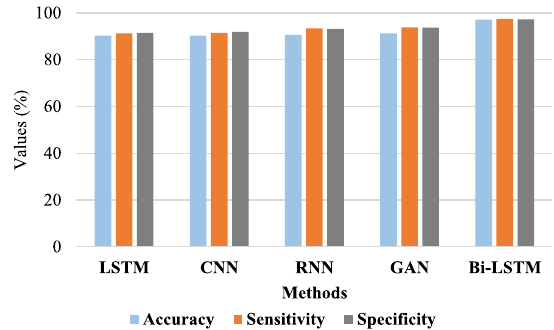
Fig. 9 Comparison of deep learning methods on AID dataset